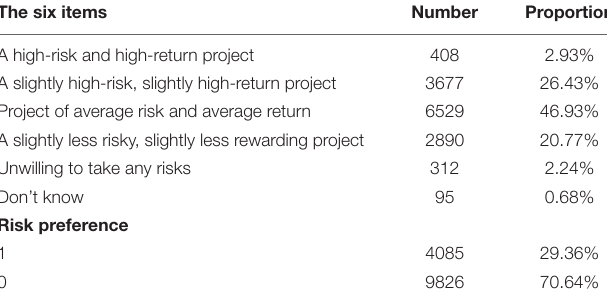
TABLE 3 | The summary of risk